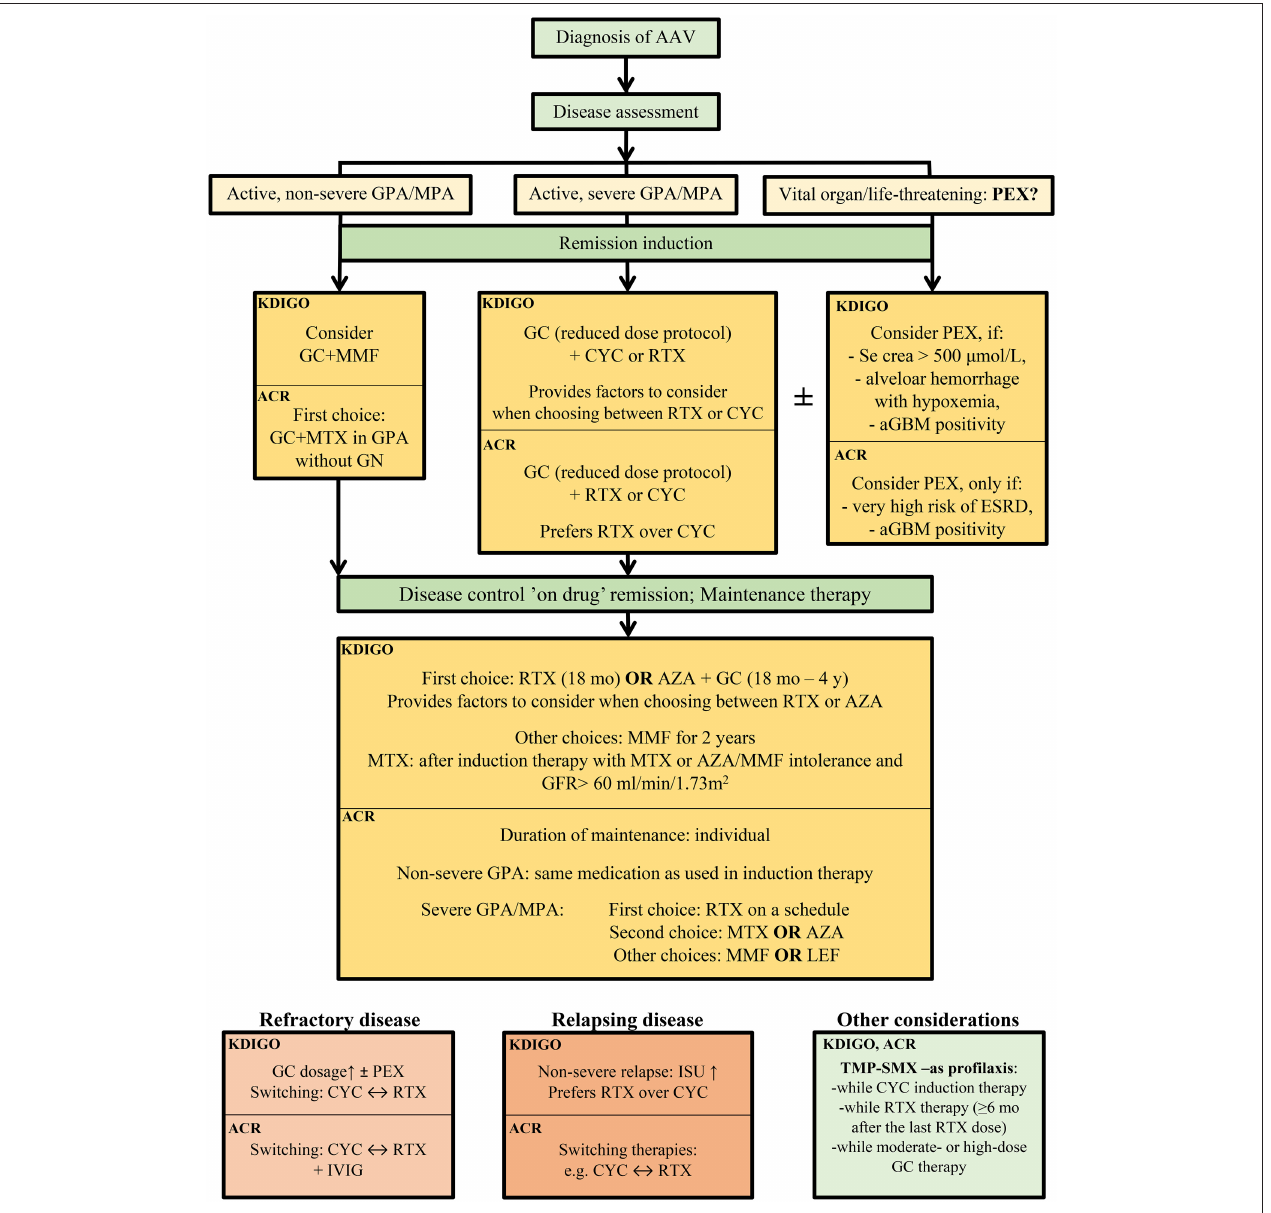
FIGURE 3 | Therapeutic recommendation of the remission induction therapy in ANCA-associated glomerulonephritis, according the current guidelines, KDIGO 2021 Clinical Practice Guideline for the Management of Glomerular Diseases (43) and American College of Rheumatology 2021 (113). AAV, ANCA-associated vasculitis; KDIGO, Kidney Disease Improving Global Outcome; ACR, American College of Rheumatology; aGBM, anti-glomerular basal membrane antibody; AZA, azathioprine; crea, creatinine; CYC; cyclophosphamide; ESRD; end-stage renal disease; GC, glucocorticoids; GFR, glomerular filtration rate; GN, glomerulonephritis; GPA, granulomatosis with polyangiitis; ISU, immunosuppressive therapy; IVIG, intravenous immunoglobulin; LEF, leflunomide; MMF, mycophenolate mofetil; mo, months; MPA, microscopic polyangiitis; MTX; methotrexate; PEX; plasma exchange; RTX, rituximab; TMP-SMX, trimethoprim/sulfamethoxazole; y,